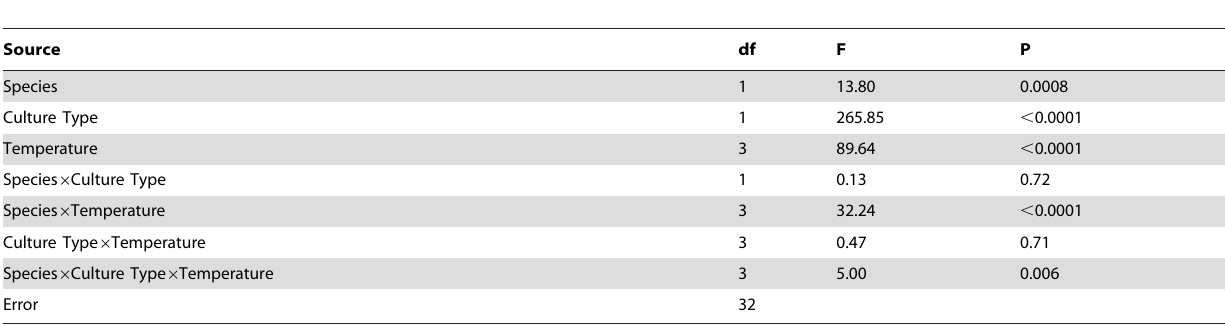
Table 3. Analysis of variance (ANOVA) results for the net reproductive rate ( R 0 ) of Liriomyza sativae and L. trifolii in pure and mixed cultures maintained at four different temperatures #